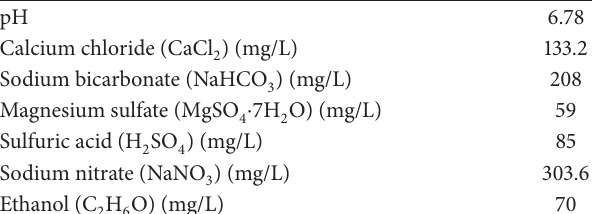
Table 1: Chemical composition of synthetic